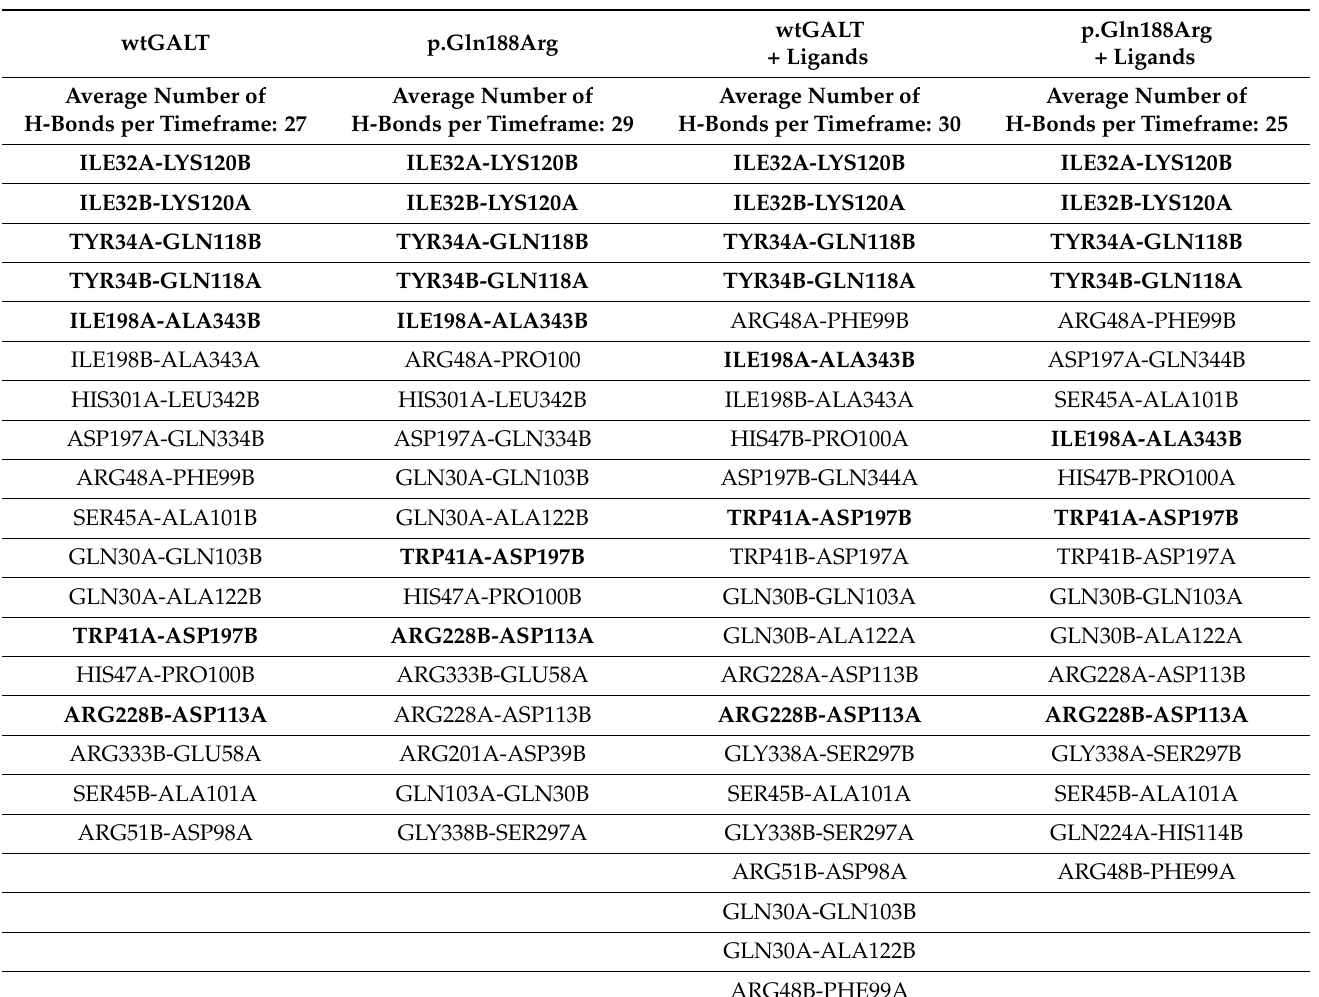
Table 1. Couples of residues involved in stable intersubunit H-bonds in simulations at 310 K. Dark gray background: intersubunit interactions identified in the initial models and conserved throughout the simulations; bold: stable interactions present in all systems. Couples of residues are considered to have a stable H-bond interaction when the sum of % of existence of the H-bonds between the two residues is ≥